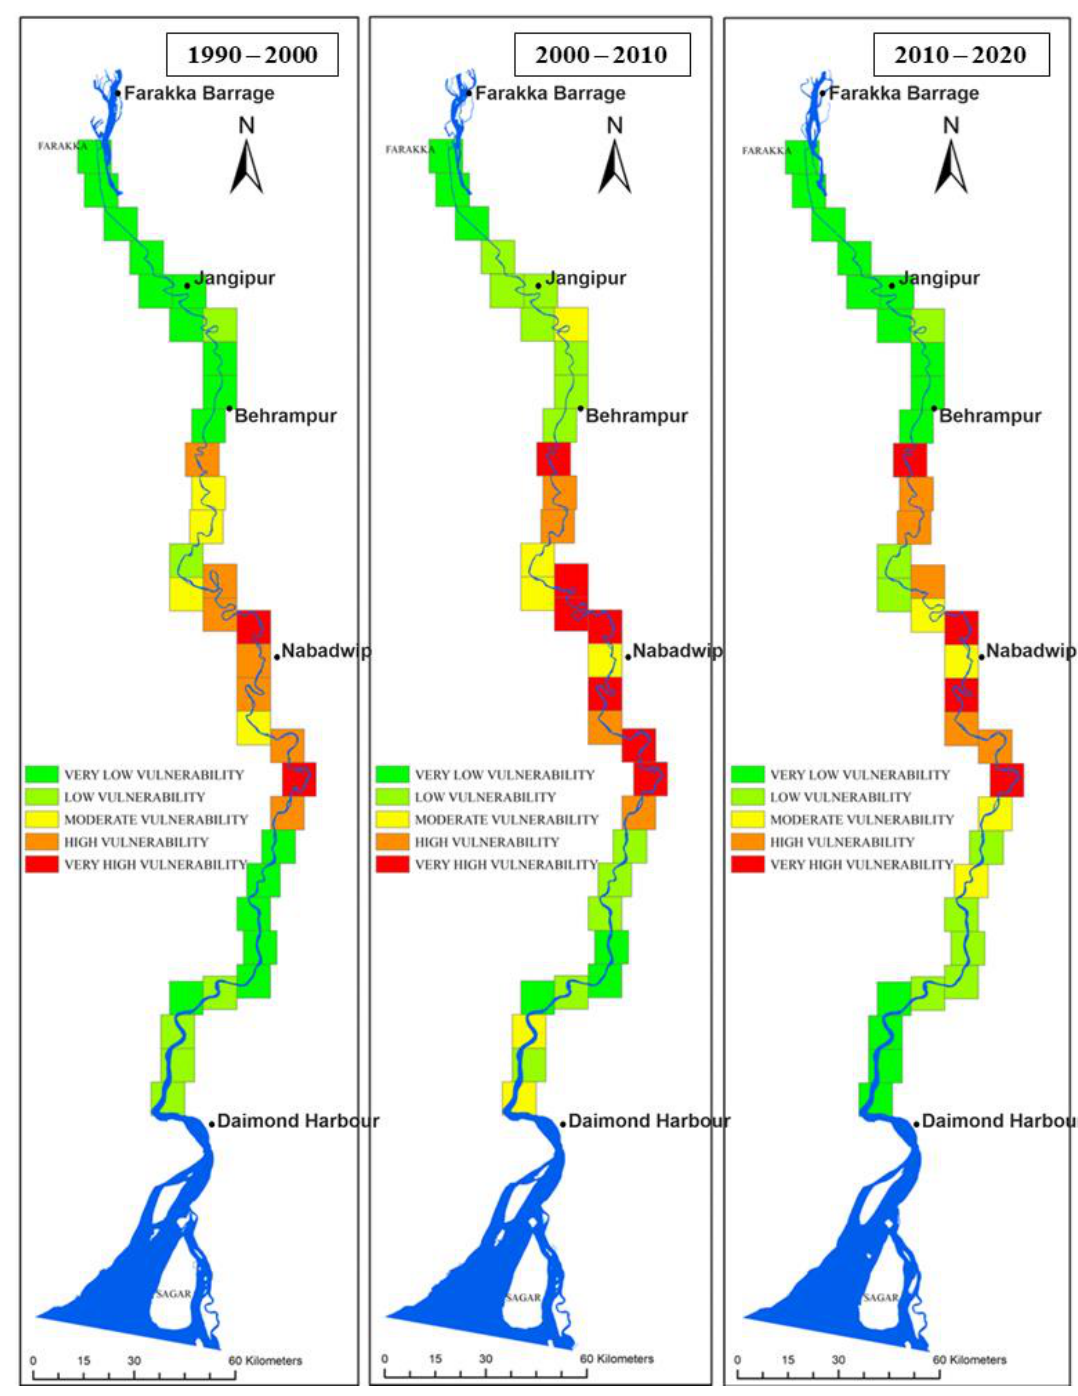
Figure 4. Erosion vulnerability zones along the Bhagirathi - Hugli River during selected periods.